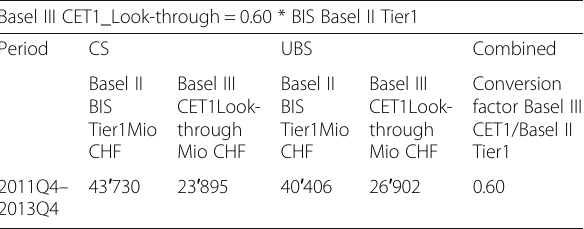
Table 10 Conversion factor: Basel III Tier1 Look-through to Basel II Tier1